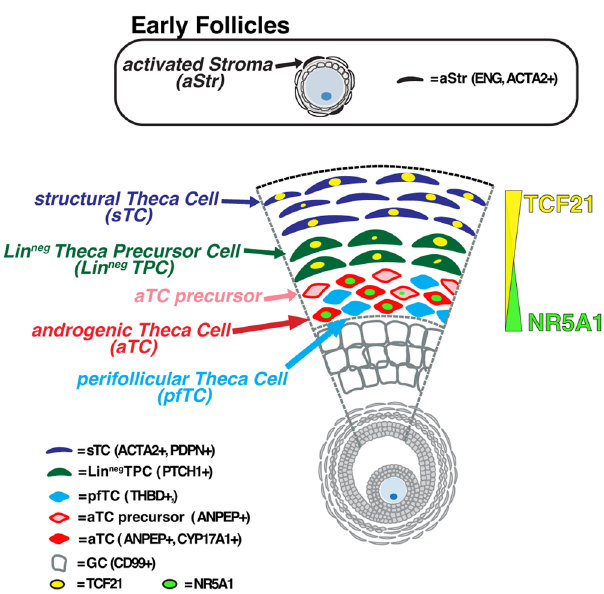
Fig. 6 Proposed model of Theca differentiation. In early growing follicles, including primary and secondary stages, activated (ENG + , ACTA2 + ) cells are identi fi able near the follicular basal membrane. These cells differentiate to the multiple cell lineages observed within the theca layer of antral follicles, which include sTCs (ACTA2 + , PDPN + , TCF21 + /neg ), aTCs (ANPEP + CYP17A1 + /neg ), and pfTCs (ANPEP neg THBD + ) as well as Lin neg TPCs (PTCH1 + Lin neg ) with multilineage potential. Differentiation along this trajectory is driven by a reciprocal expression pattern of the transcription factors TCF21 and NR5A1, which govern speci fi cation of sTC and aTC identity,